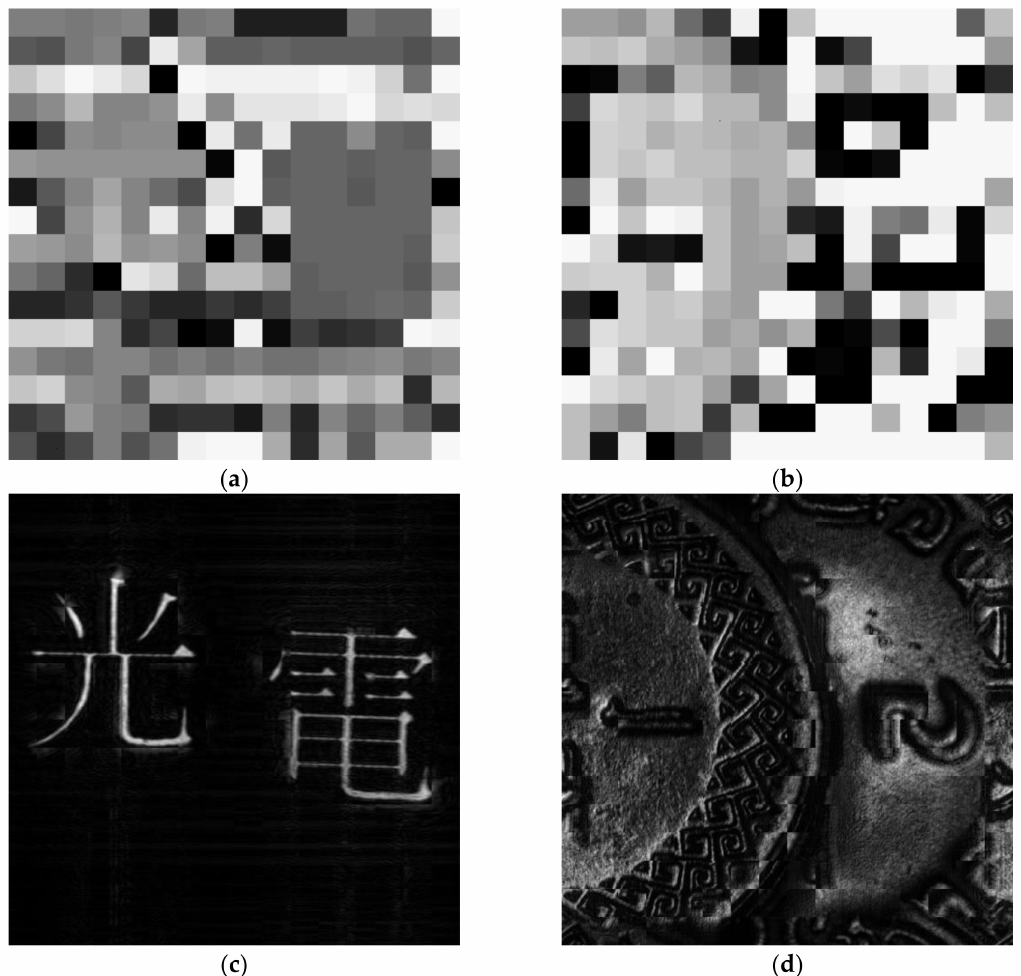
Figure 6. ( a ) Depth map of hologram “A” obtained with our proposed method ( M = 32) without filtering; ( b ) Depth map of hologram “B” obtained with our proposed method ( M = 32) without filtering; ( c ) Extended depth of field (EDF) image of hologram “A” reconstructed with our proposed method ( M = 32) without filtering on the depth map; ( d ) EDF image of hologram “B” reconstructed with our proposed method ( M = 32) without filtering on the depth